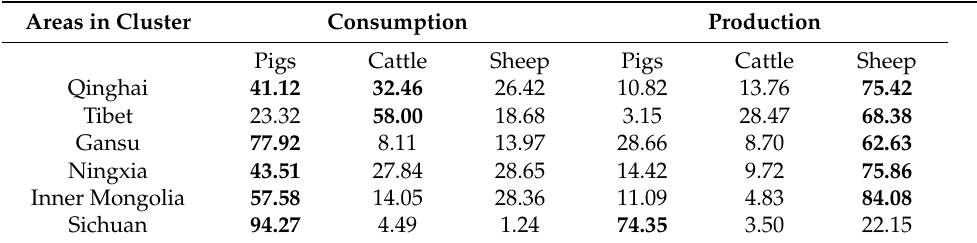
Table 5. Production and consumption distribution of meat in clusters areas (recurrence period) (%).